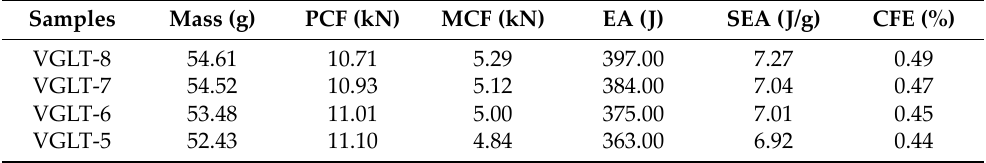
Table 8. Energy absorption parameters of the VGLT model with different gradient configurations.